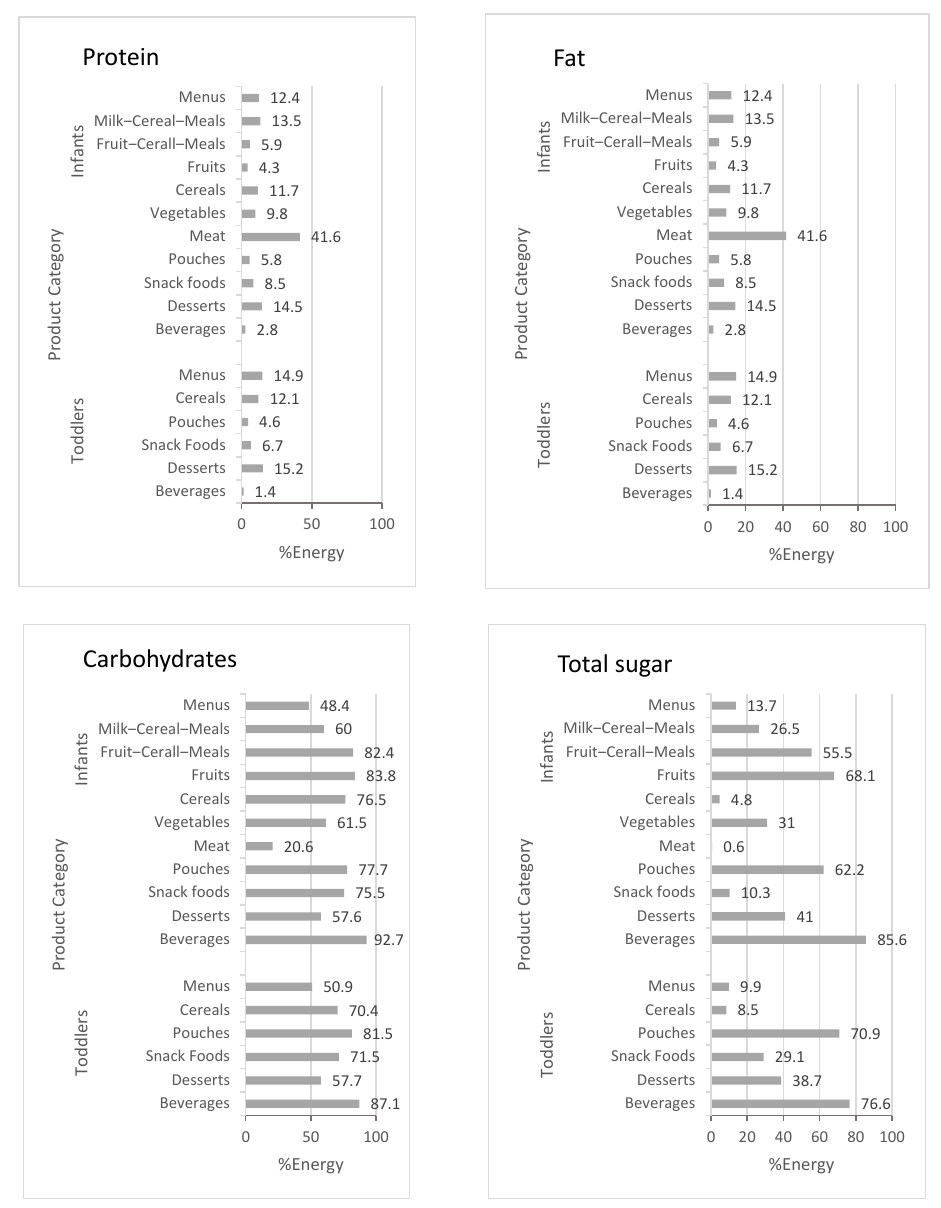
Figure 1. Declared macronutrient content (% of energy content) of commercial complementary food products (means of product category), results of a 2020 market survey in Germany. Table 3. Nutrient fortification 1 in commercial complementary foods (CCF), results of a 2020 market survey in Germany 2